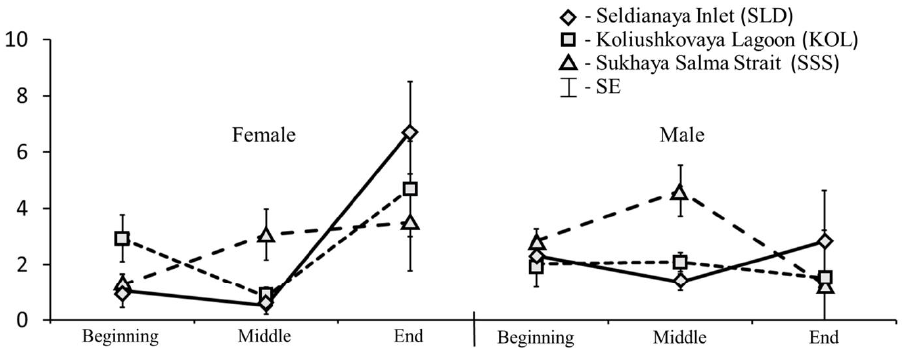
Figure 2. Feeding intensity of threespine stickleback during the spawning season. The Y-axis represents stomach fullness index FI ( ‱ ). The dots and bars represent the sample means and standard errors (SE).